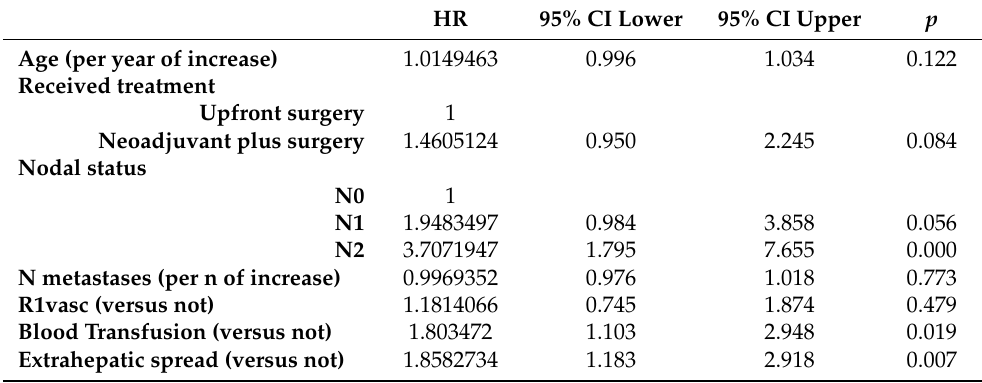
Table A2. Double robust test with Cox regression in the weighted population to estimate the risk of